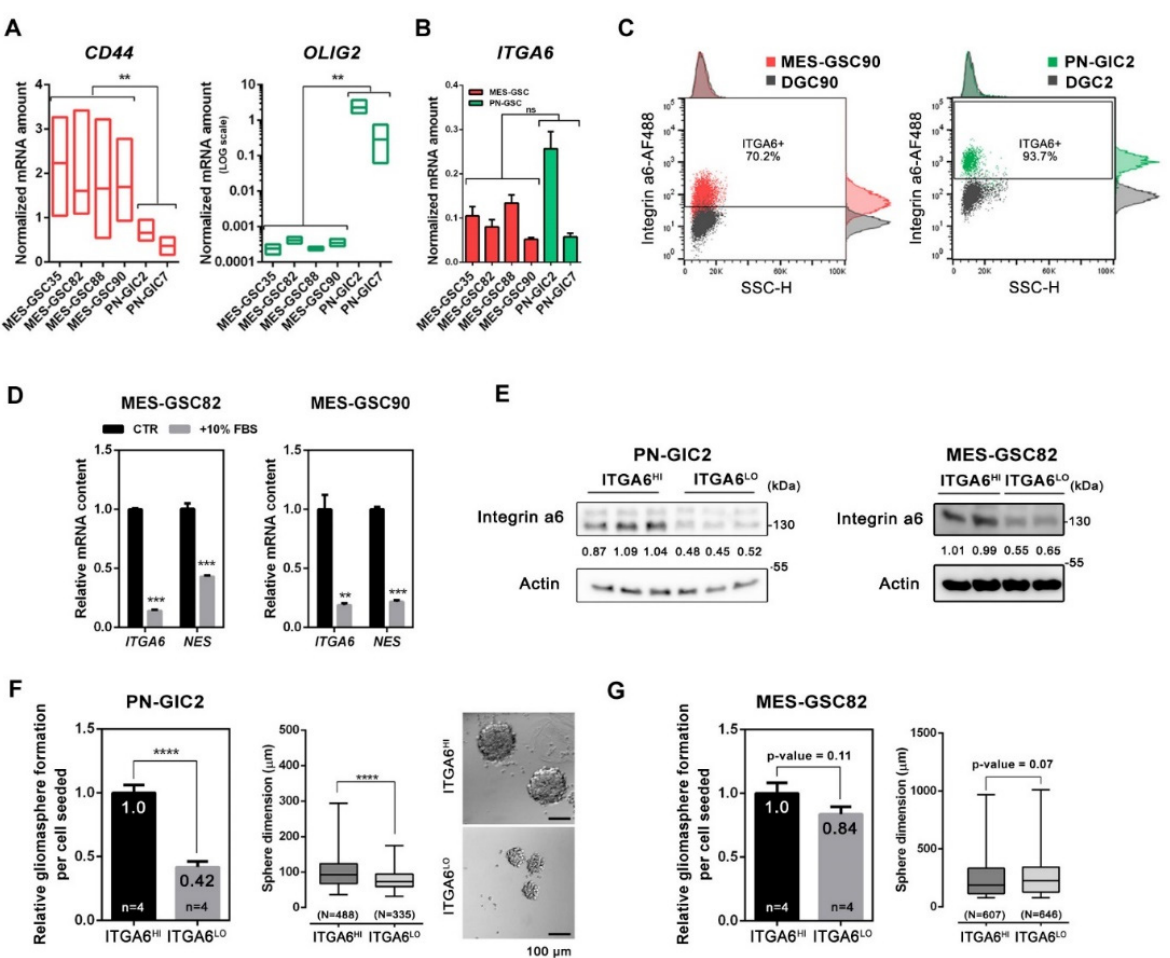
Figure 1. Integrin a6 expression in PN and MES-GSCs. ( A ) Analysis of GSCs from our collection according to the expression of CD44 and OLIG2 by q-PCR. The gene expression was calculated using the dCt (unpaired t -test with Welch’s correction). ( B ) Expression levels of the ITGA6 gene across MES-GSCs (depicted in red) and PN-GSCs (depicted in green). Mean expression was calculated with the dCt method (mean ± SEM; n = 3; unpaired t -test with Welch’s correction). ( C ) Representative flow cytometry analysis of integrin a6 in MES-GSC90 and PN-GIC2 with relative differentiated glioblastoma cells (DGCs) as an internal negative control (Figure S2C). ( D ) ITGA6 and NES mRNA levels after 7 days of differentiation in 10% FBS containing media (mean ± SEM; n = 3; unpaired t -test). ( E ) Western blot validation of PN and MES-GSCs enriched for integrin a6 high MFI (median fluorescence intensity; HI) or low MFI (LO) via FACS sorting. The values indicated within blots are relative to the densitometric analysis. Numbers indicate the normalized integrin a6 intensity ratio relative to the mean of normalized ITGA6HI samples. ( F and G ) Assessment of self-renewal capacity (mean ± SEM; unpaired t -test) and sphere size (mean ± SEM; Mann–Whitney test) in PN-GSCs ( F ) and MES-GSCs ( G ) enriched or depleted according to the ITGA6 expression. Representative micrographs of gliomaspheres formed from PN-GIC2 enriched for ITGA6 high-expressing and low-expressing cells. The number of independent experiments— n , the number of gliomaspheres scored for each condition—N. The values specified within the bar plot indicate the mean relative self-renewal capacity. * p < 0.05; ** p < 0.01; *** p < 0.001; **** p < 0.0001